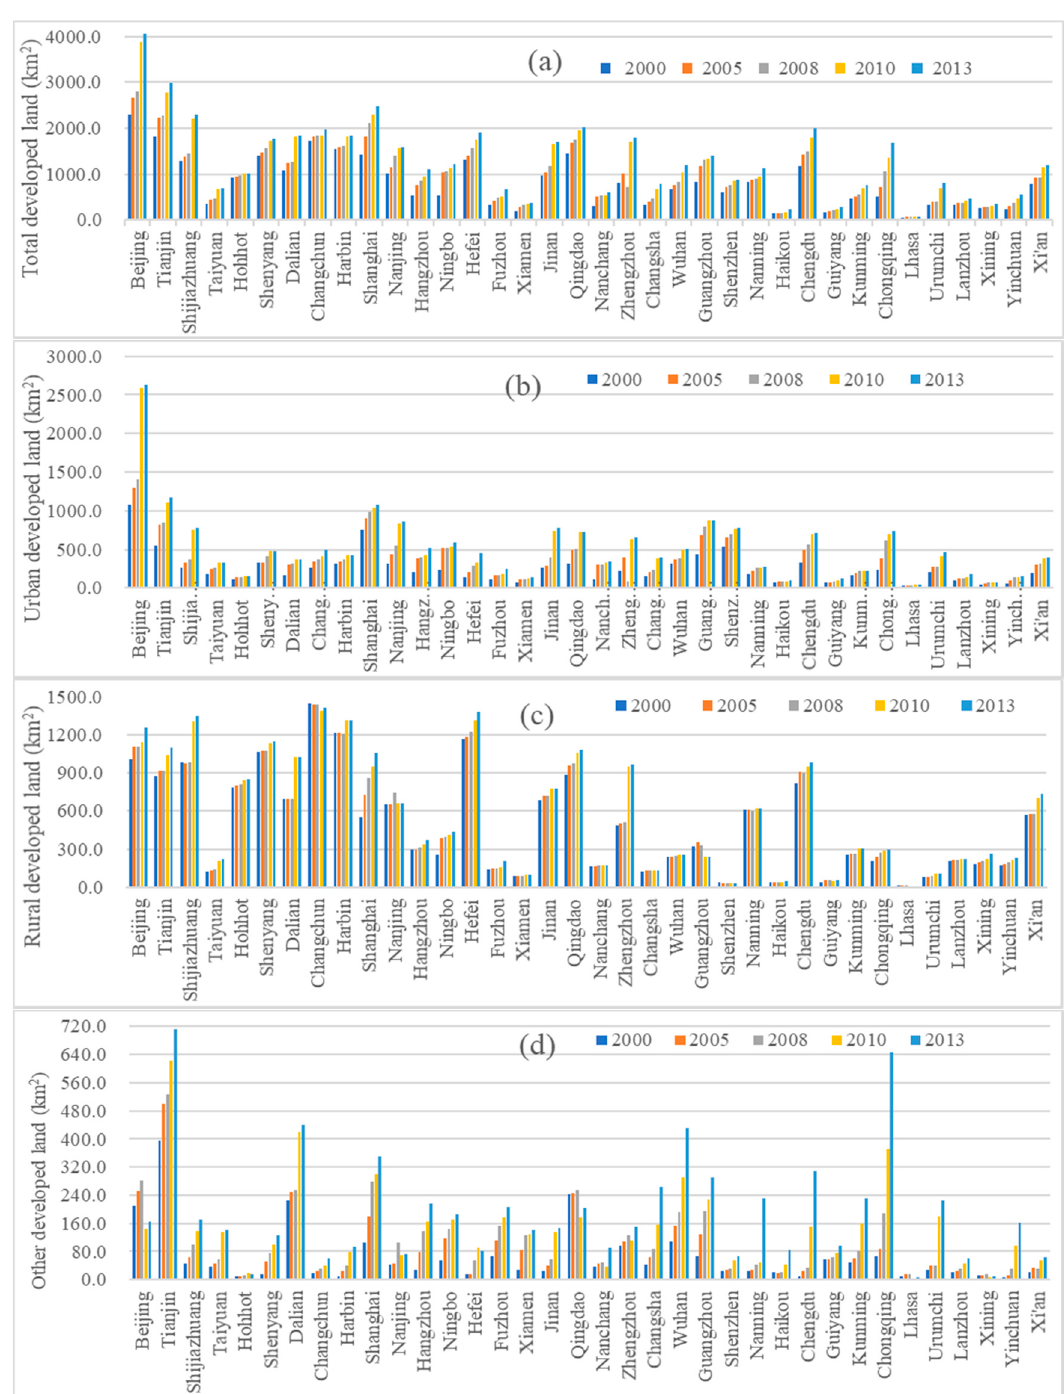
Figure 3. Dynamics of the developed land within the city’s boundary in 2000–2013: ( a ) total, ( b ) urban, ( c ) rural, and ( d ) other developed land.